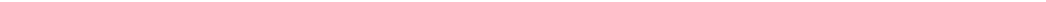
Figure 3: HCV RNA stability in dried blood spot samples (DBS) exposed to room temperature for 7 days prior to storage at 20°C Gt = geno- type; Xpert ® HCV VL = Xpert® HCV Viral Load test; RT = room temperature; DBS 0–2d RT = DBS stored at –20°C within 48 hours after capil- lary blood draw; DBS 7d RT = DBS exposed to room temperature for 7 days prior to storage at –20°C; DBS 9d RT = DBS exposed to room temperature for 9 days prior to storage at –20°C; DBS 12d RT = DBS exposed to room temperature for 12 days prior to storage at